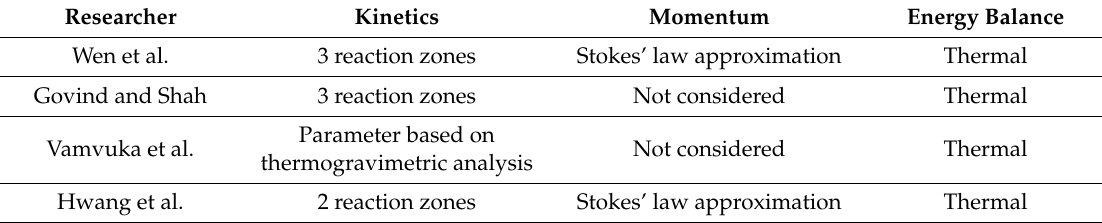
Table 1. Texaco pilot plant entrained flow gasifier (EFG) model based on the Electric Power Research Institute (EPRI) data. Researcher Kinetics Momentum Energy Balance Wen et al. 3 reaction zones Stokes’ law approximation Thermal Govind and Shah 3 reaction zones Not considered Thermal Parameter based on Not considered Thermal Vamvuka et al. thermogravimetric analysis Hwang et al. Stokes’ law approximation